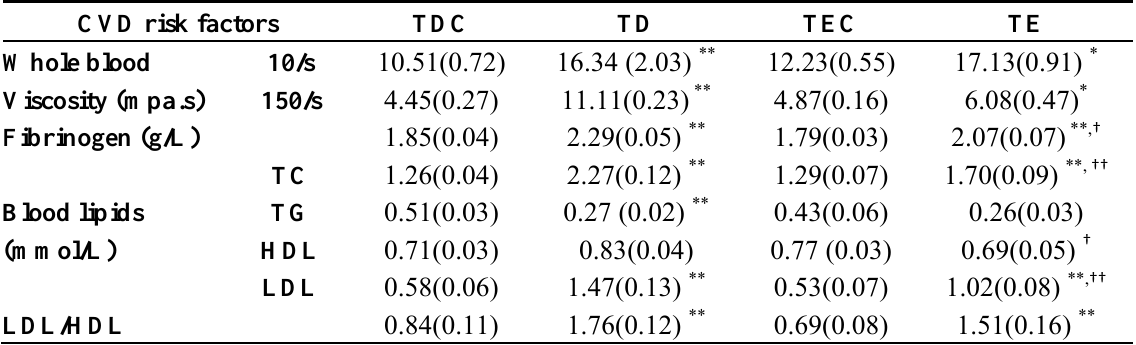
Table 1. Effects of the temperature dropping process on WBV, FG, and blood lipids (mean (SE), n = 6 in each group) CVD risk factors Viscosity (mpa.s)